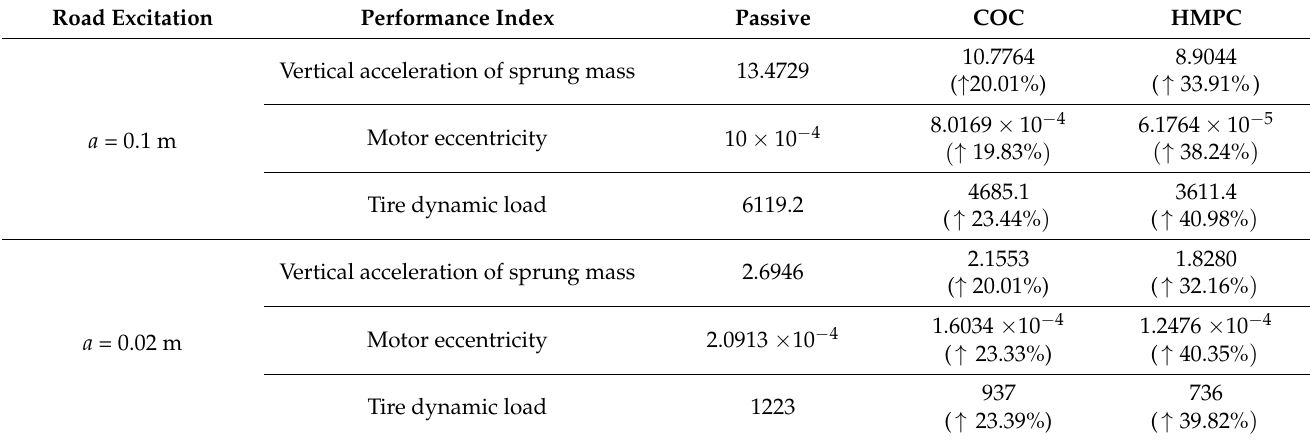
Table 4. The peak-to-peak (PTP) values of HM-EV evaluation